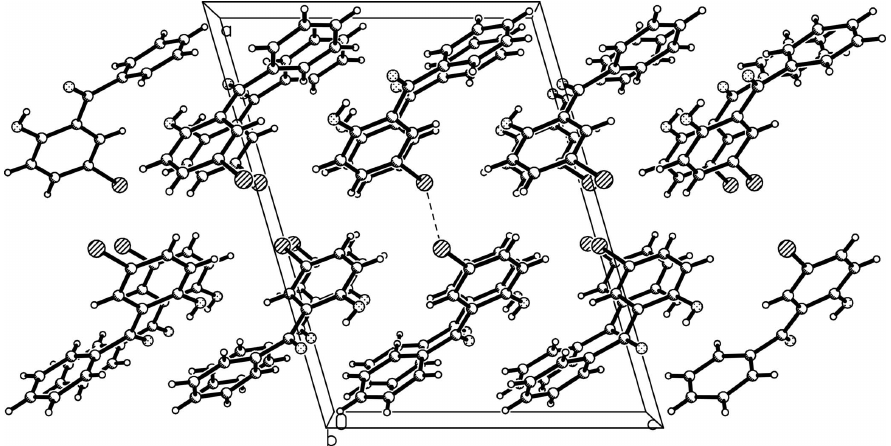
The packing of (I), viewed down the b